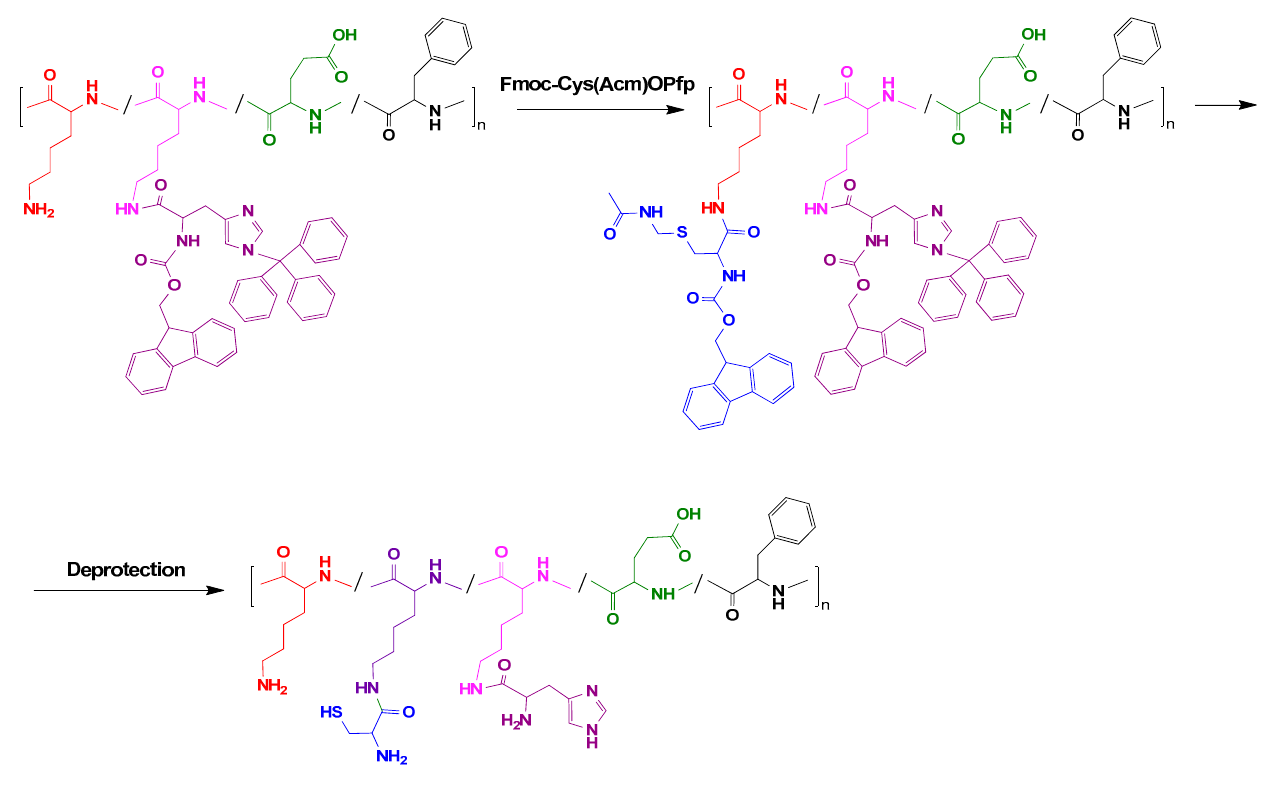
Figure 2. Scheme of the synthesis of a cysteine-containing polypeptide by the example of the P(Lys- co -Lys(His)- co -Glu- co -Phe) modification.